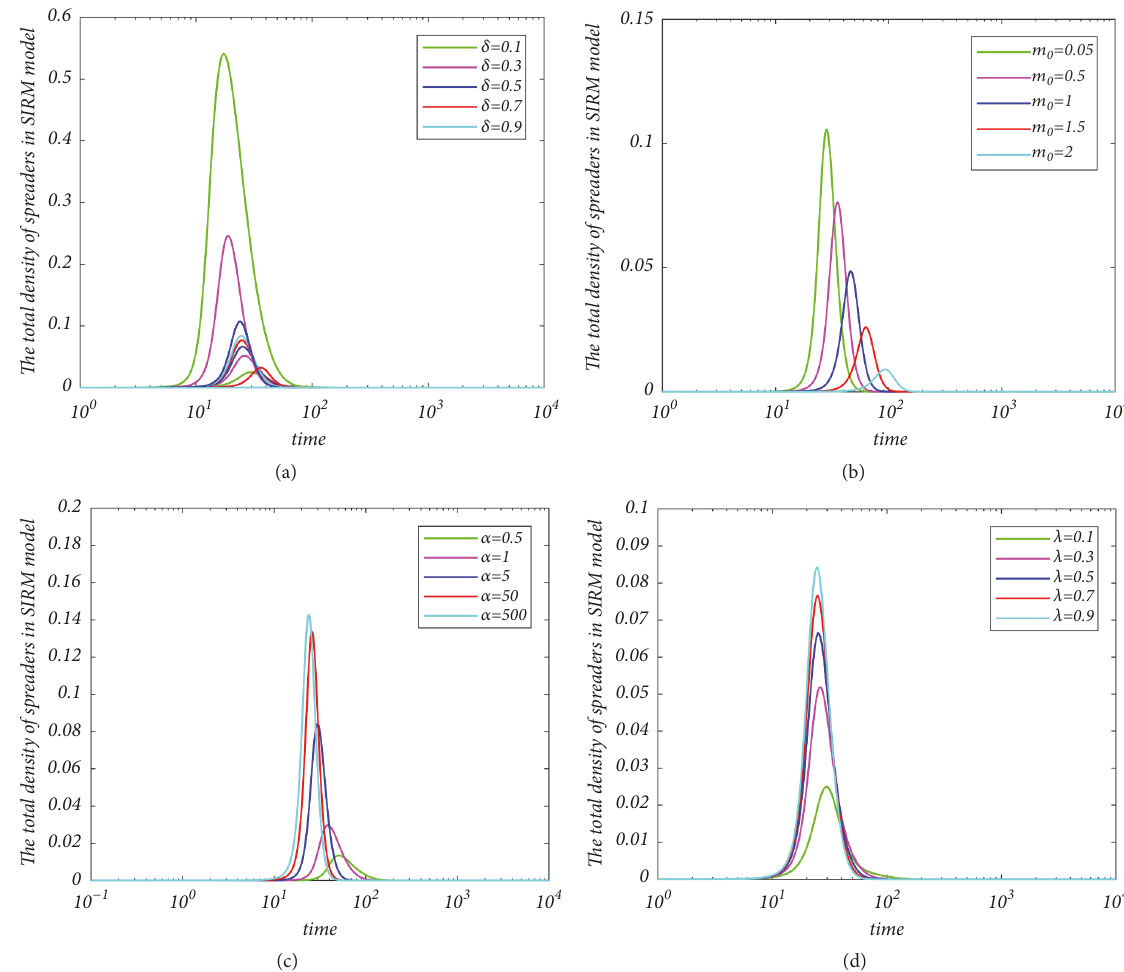
Figure 3: The impact of different values of 𝛿, 𝑚 0 ,𝛼, 𝜆 on the total density of spreaders when R 0 < 1